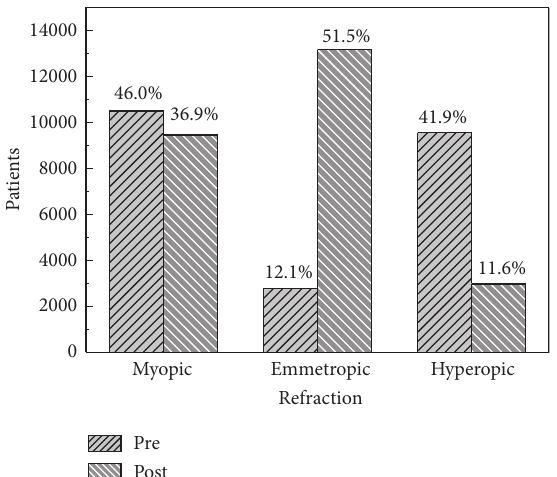
Figure 5: Classification of the refraction, preoperative and postoperative. Note that the total number of patients in the preoperative and postoperative stages is different (see Table